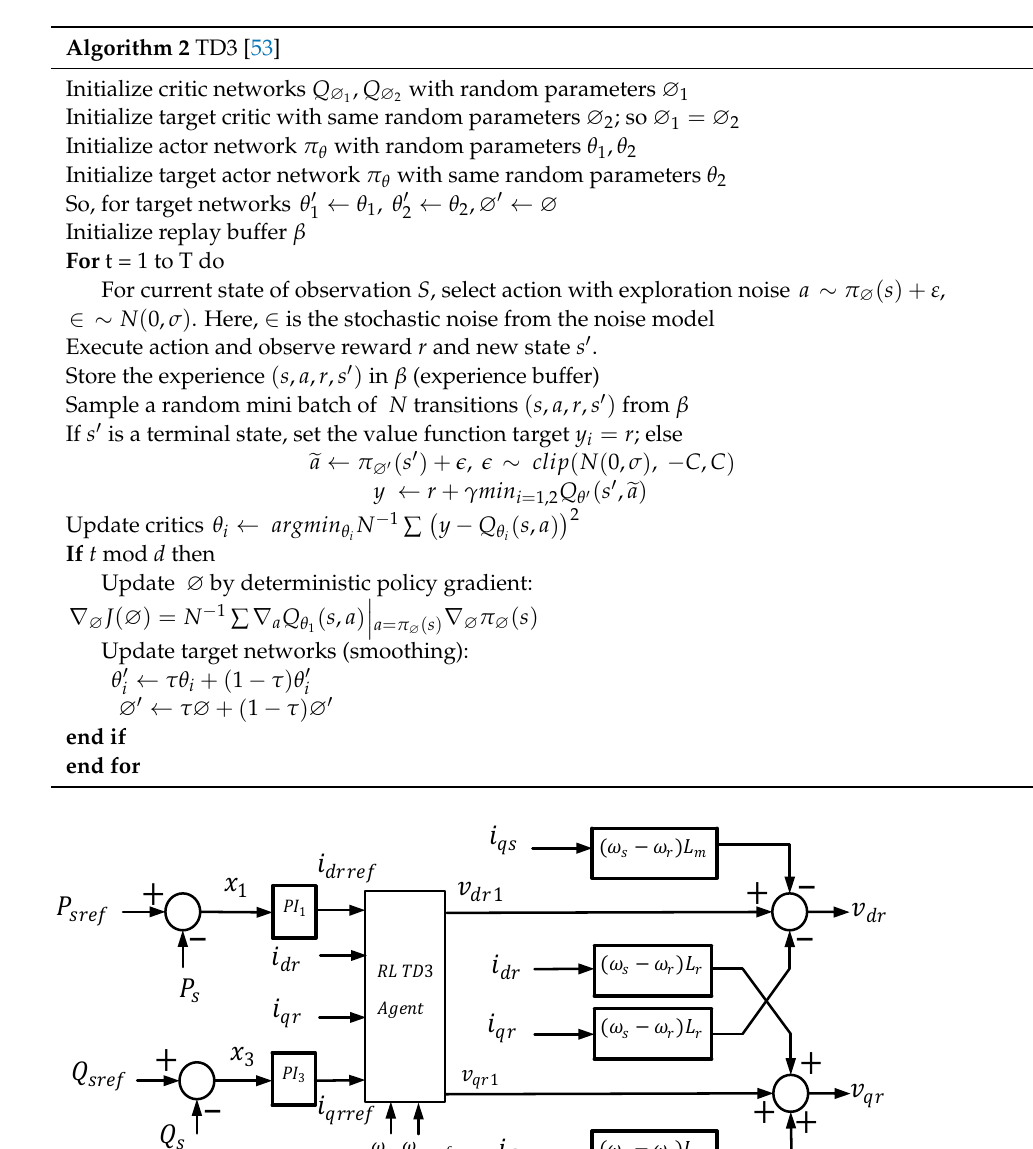
Figure 15. TD3 agent training progress. 7. Results and Discussion 7.1. Simulation Results with the Newly Designed PSS The model discussed in this paper was built in MATLAB/Simulink. The topology is shown in Figure 13. There have been extensive works published based on simulations [4,10,35,55]. A small ‐ signal model was developed to identify the state variables that affect the stability of the overall system. From the small ‐ signal model, the sensitive variables observed are 𝑖 (cid:3031)(cid:3045) , 𝑖 (cid:3044)(cid:3045) , 𝑖 (cid:3044)(cid:3046) , 𝑥 (cid:2875) , 𝑣 (cid:3031)(cid:3046) , and 𝜃 (cid:3043)(cid:3039)(cid:3039) . The input given to the power system stabilizer